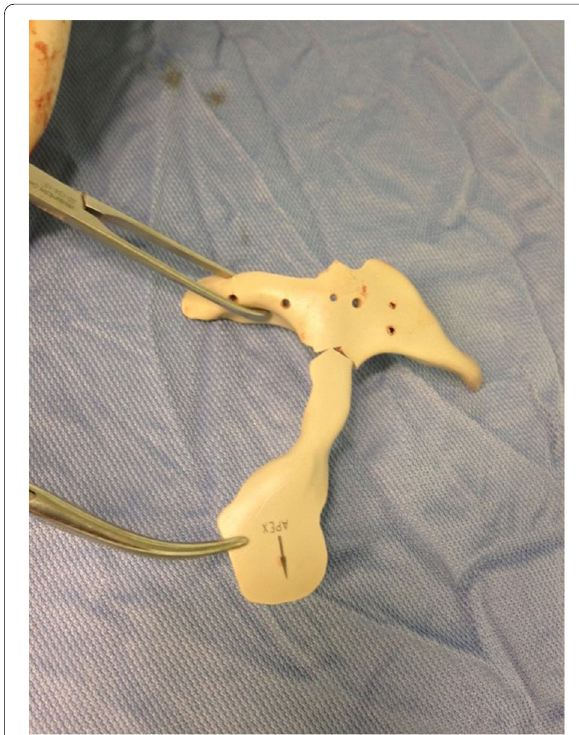
Fig. 5 Zigomatic implant initially planned as one piece which was impossible to insert, the implant had then to be split in two parts